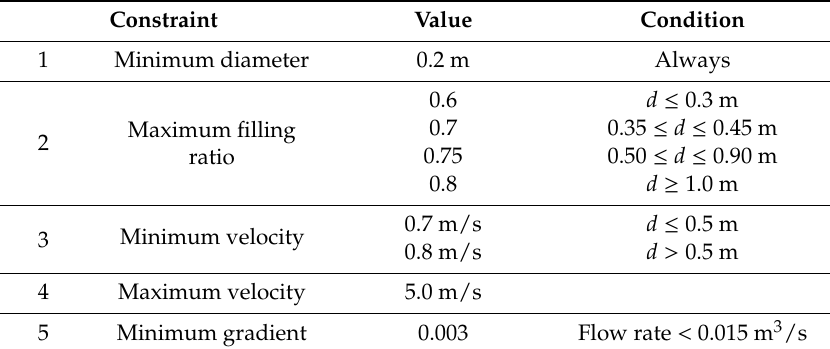
Table 1. Hydraulic design constraints for round pipes